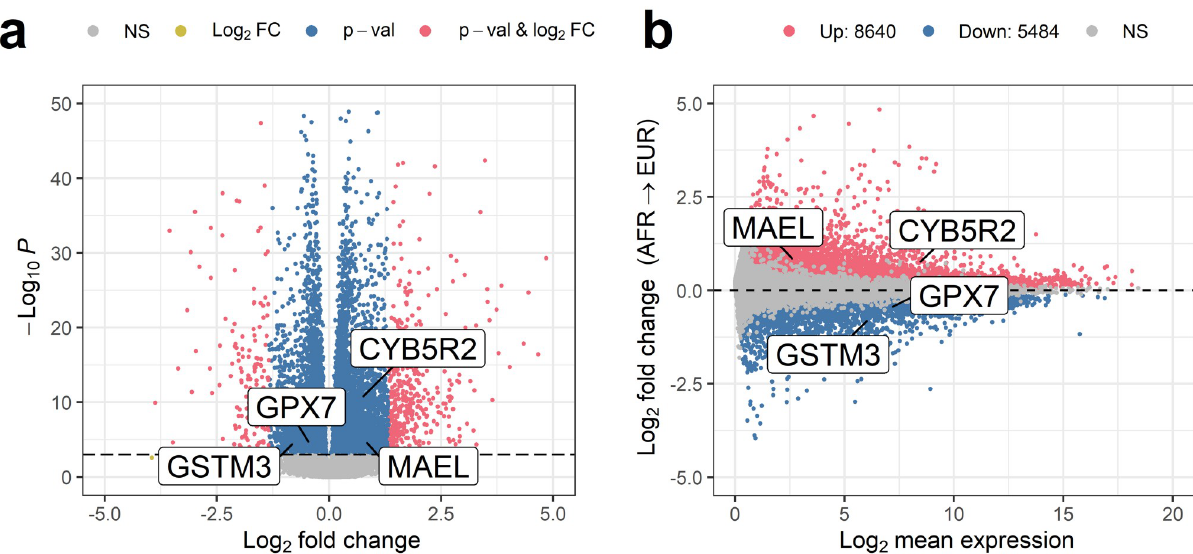
Fig 2. Gene expression inferred from whole blood RNA-seq in cohorts of 89 Africans and 373 Europeans. a , Volcano plot reveals 14,124 (out of 60,667) differentially expressed genes. Differential expression is validated for 32 (out of 54) genes associated with an EBML/eSTRs (p = 1.08e-9; χ 2 test). Genes up regulated by EBML/eSTR microsatellites include MAEL and CYB5R2; genes down regulated by EBML/eSTR microsatellites include GPX7 and GSTM3. b , MA plot of gene expression fold change in 89 Africans and 373 Europeans. The 8,640 upregulated genes include 20 associated with an overlapping EBML/eSTR; the 5,484 downregulated genes include 12 associated with an overlapping EBML/eSTR. The null was not rejected (p = 1) indicating that EBML/eSTRs are not disproportionately associated with up regulation or down regulation.